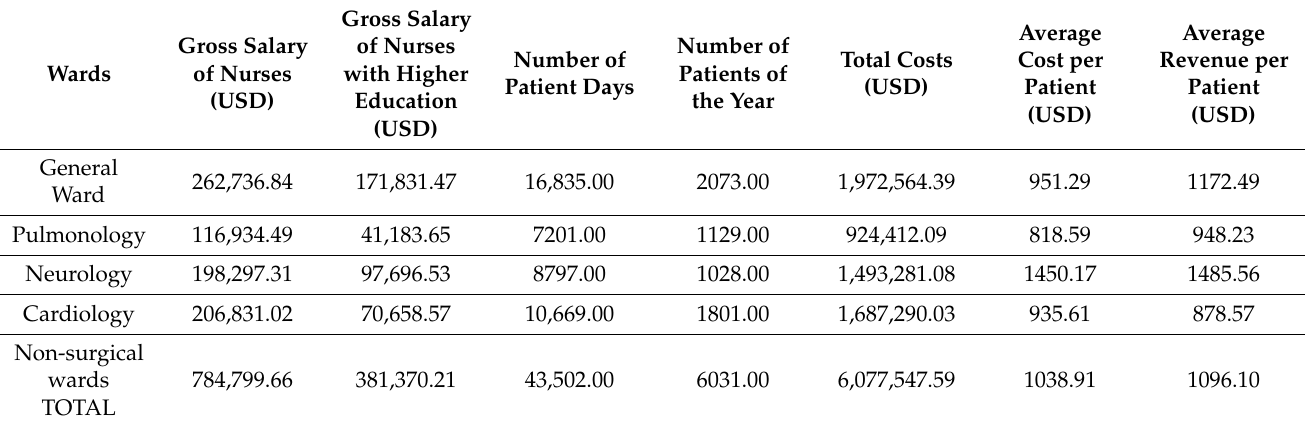
Table 3. Revenue and cost per patient by non-surgical